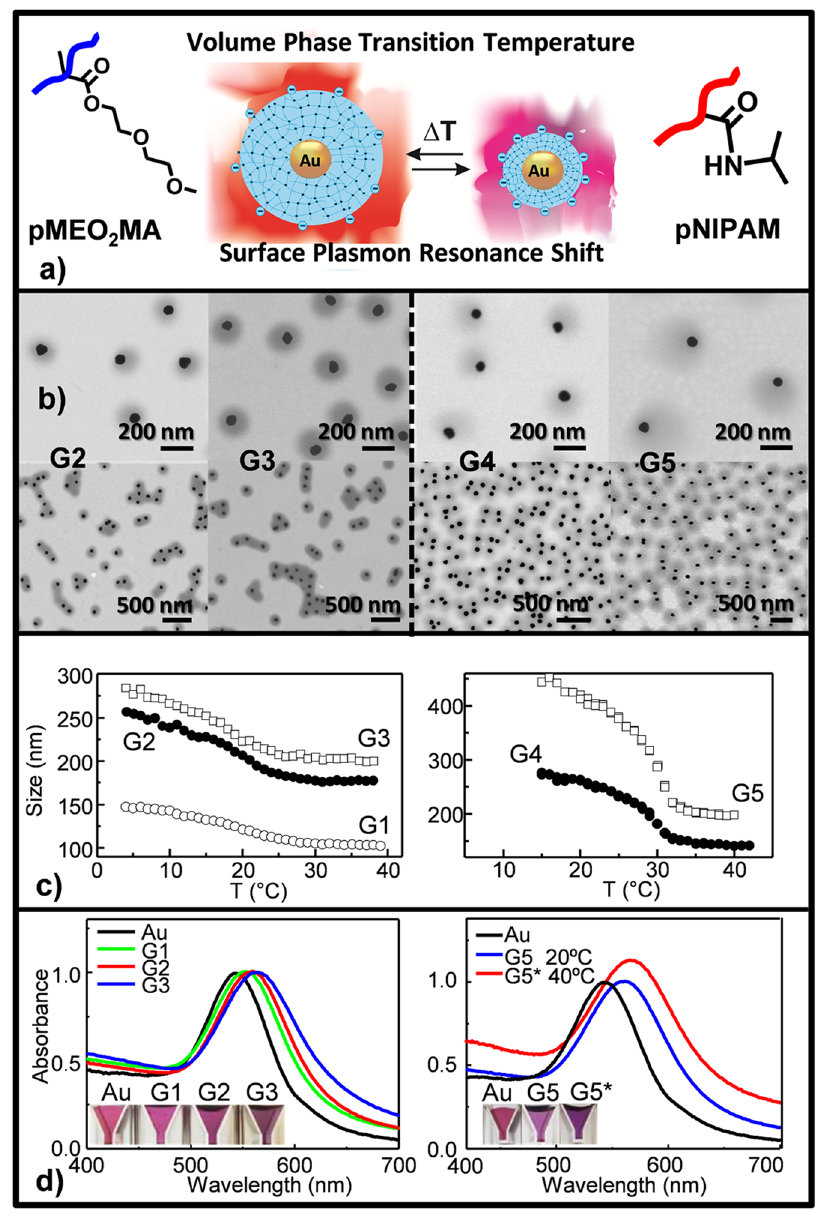
Figure 2. ( a ) Schematic illustrating temperature-induced swelling-shrinking behavior of AuNP encapsulated with pNIPAM (right) and pMEO 2 MA (left); ( b ) S-TEM images at high and low magnification and ( c ) Temperature-dependent hydrodynamic diameter evolution of AuNP@pNIPAM (right) and Au@pMEO 2 MA (left) with SDS concentration; and ( d ) UV-Vis spectra evolution of AuNPs with increasing pMEO 2 MA (left) shell thickness below VPTT, and with pNIPAM (right) encapsulation, at temperatures below (20 °C) and above (40 °C) the VPTT, for G5 sample. Insets: color variation of Au@pMEO 2 MA (left) and Au@pNIPAM (right) nanohybrid